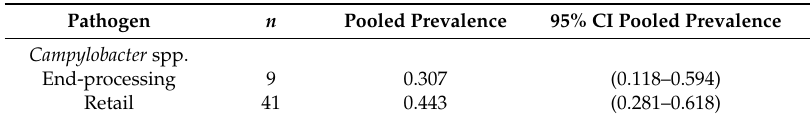
Table 2. Meta-analysis of the incidence of pathogens in poultry meat surveyed in Europe by sampling